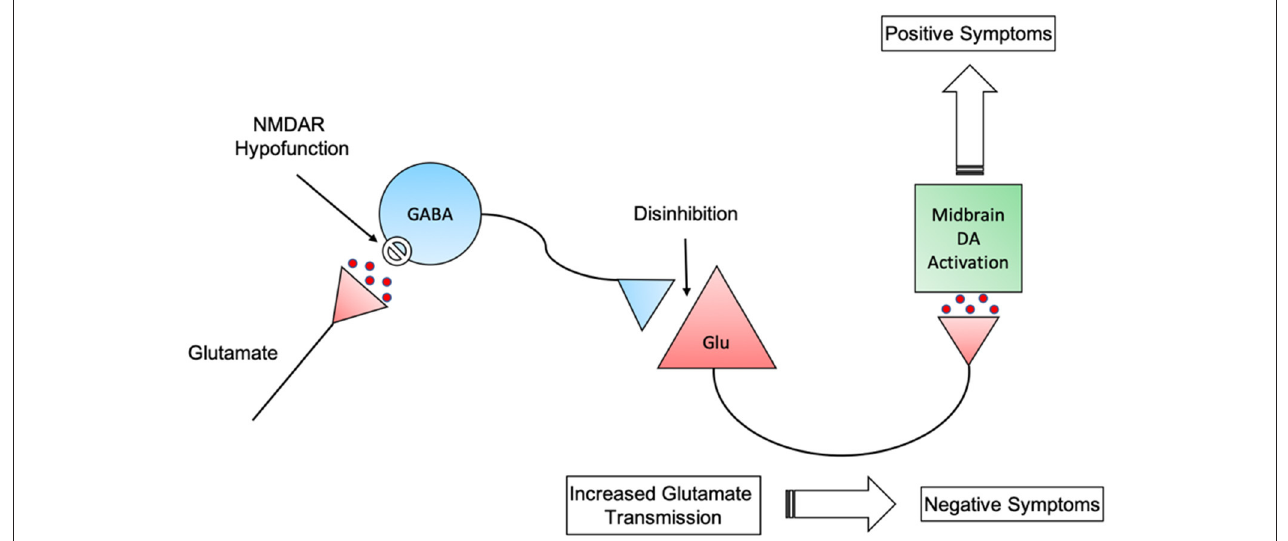
FIGURE 1 | Interactions between GABAergic disinhibition of glutamatergic neurons and subsequent stimulation of midbrain dopaminergic neurons. NMDAR, N-methyl-D-aspartate receptor; GABA, Gamma-Aminobutyric acid; Glu, Glutamate; DA,